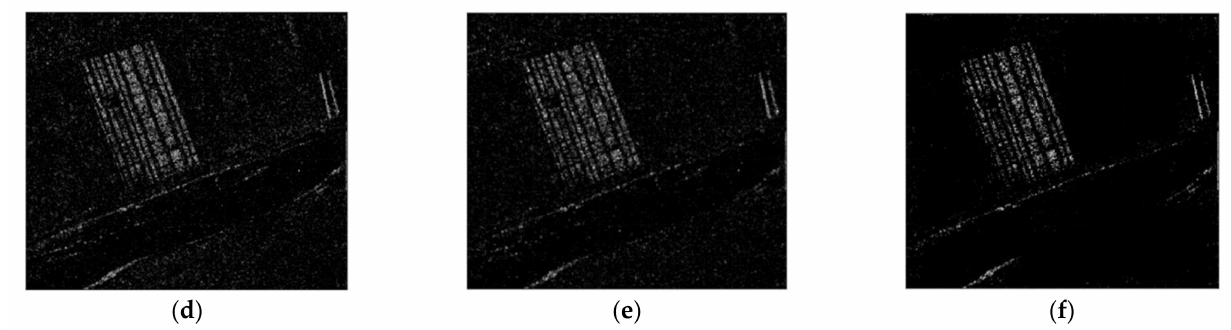
Figure 12. CDMs using dataset 3 obtained by six CD algorithms after median filtering in the post processing step. ( a ) CDM reconstructed by the CC. ( b ) CDM reconstructed by the LMT. ( c ) CDM reconstructed by the NRA. ( d ) CDM reconstructed by the SEST. ( e ) CDM reconstructed by the BGD. ( f ) CDM reconstructed by the proposed